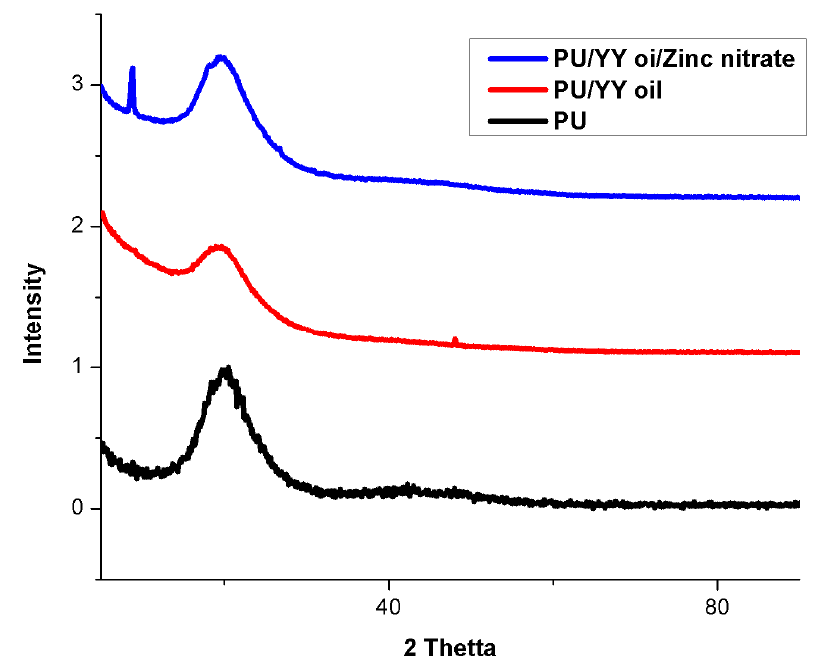
Figure 4. X-ray Di ff raction (XRD) images of PU, PU / YY and PU / YY / ZnNO Figure 4. X-ray Diffraction (XRD) images of PU, PU/YY and PU/YY/ZnNO 3.